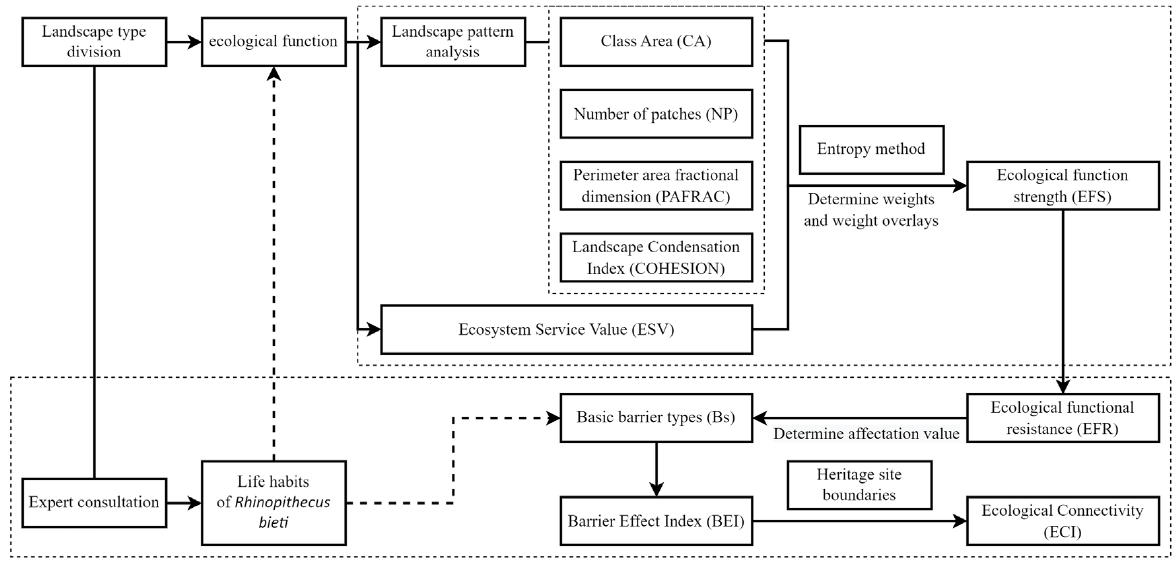
Figure 2. Article Figure 2. Article flowchart.